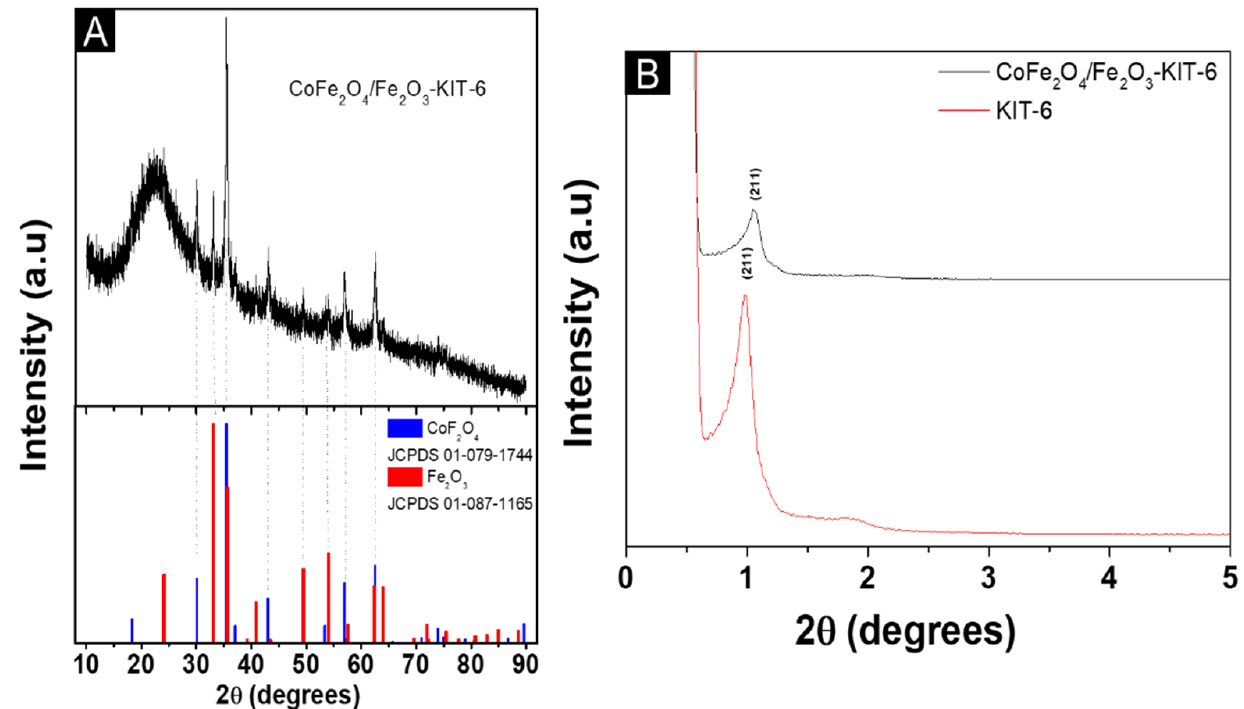
Figure 1. The X-ray diffractogram of the solids: ( A ) wide angle; ( B ) Low-angle.